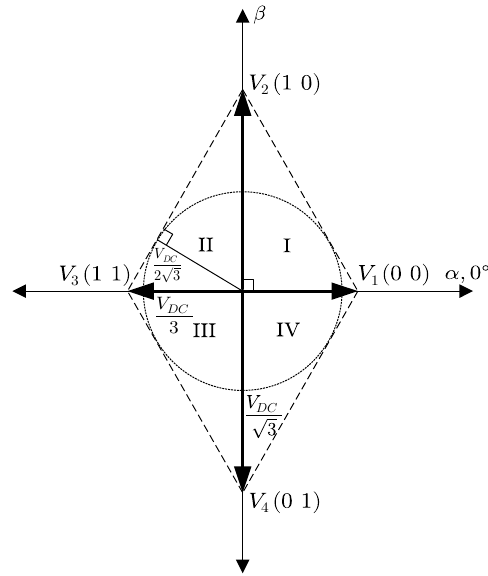
Figure 4. Space vector representations for an FSTP inverter [49].